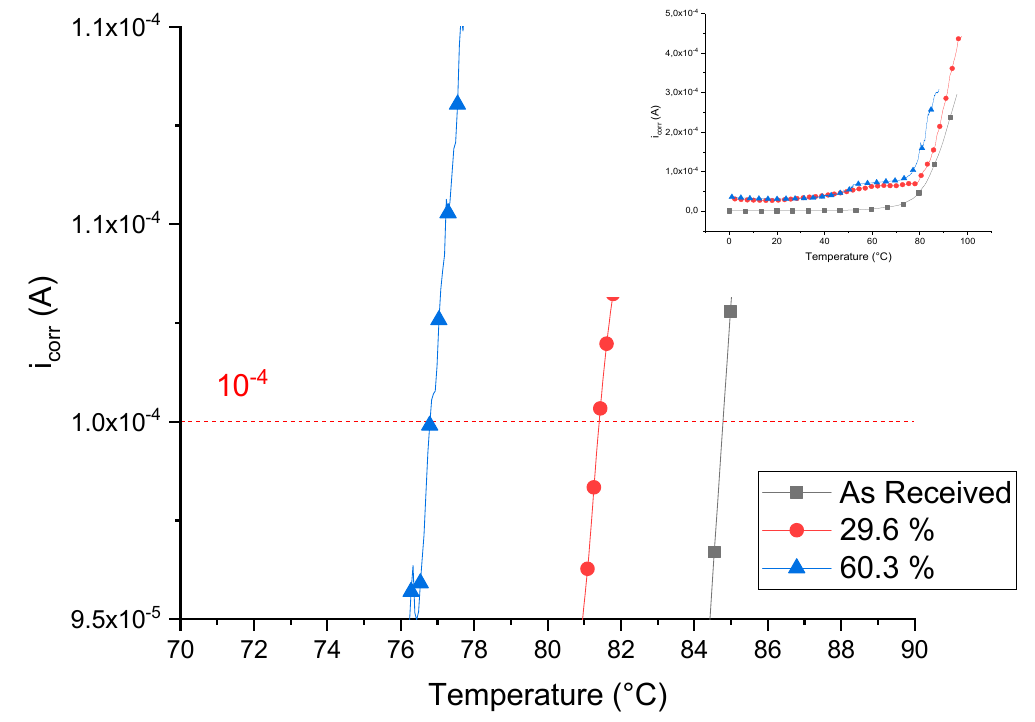
Figure 8. Close-up of the region of interest of the critical pitting temperature (CPT) curves of welded sheet metal.